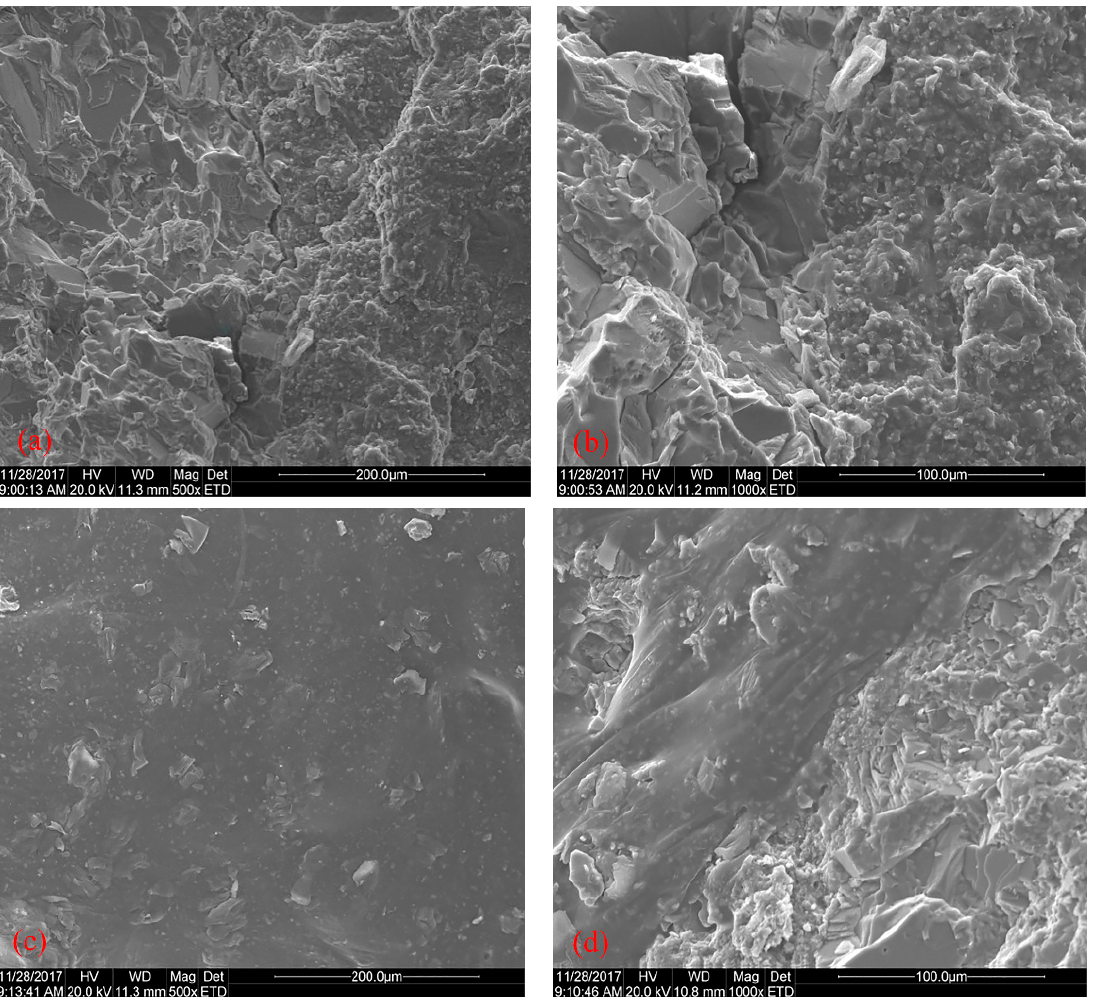
Figure 7. The SEM images of the ( a ) QRA mix (200 μ m); ( b ) QRA mix (100 μ m); ( c ) TLA mix (200 μ m) and ( d ) TLA mix (100 μ